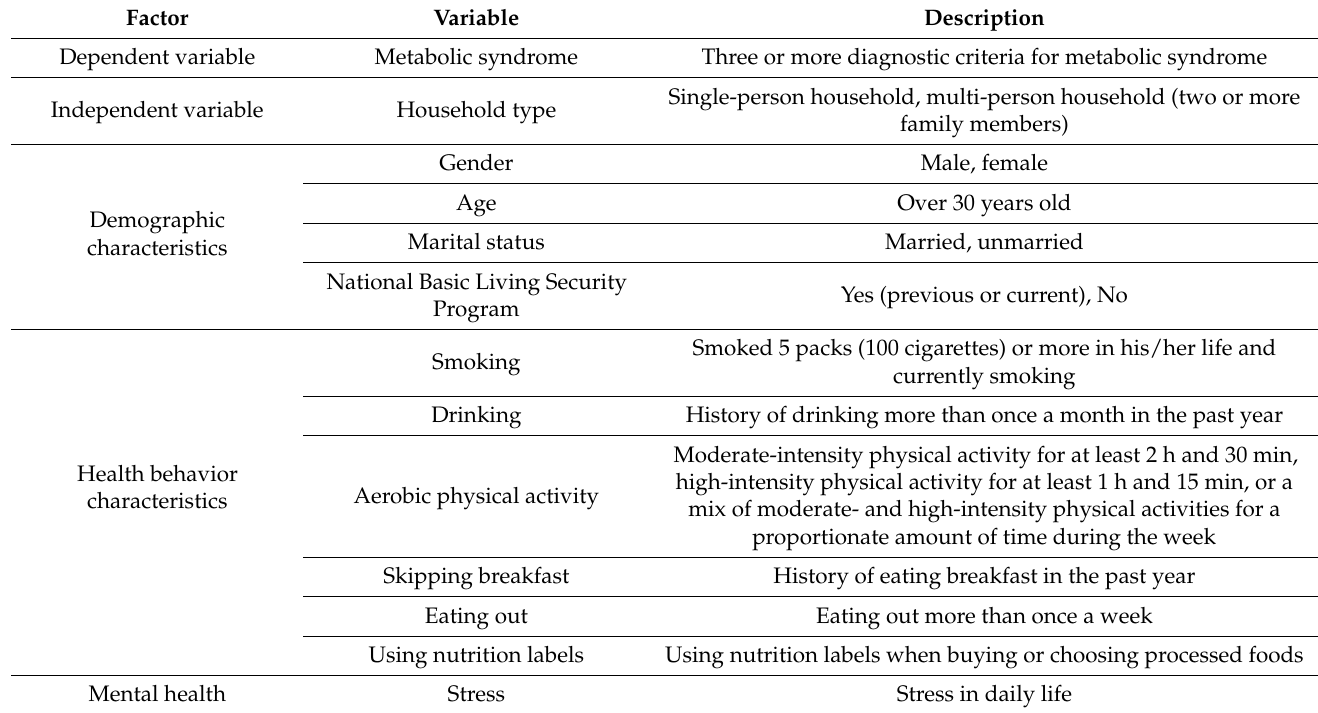
Table 1. Definition of the study